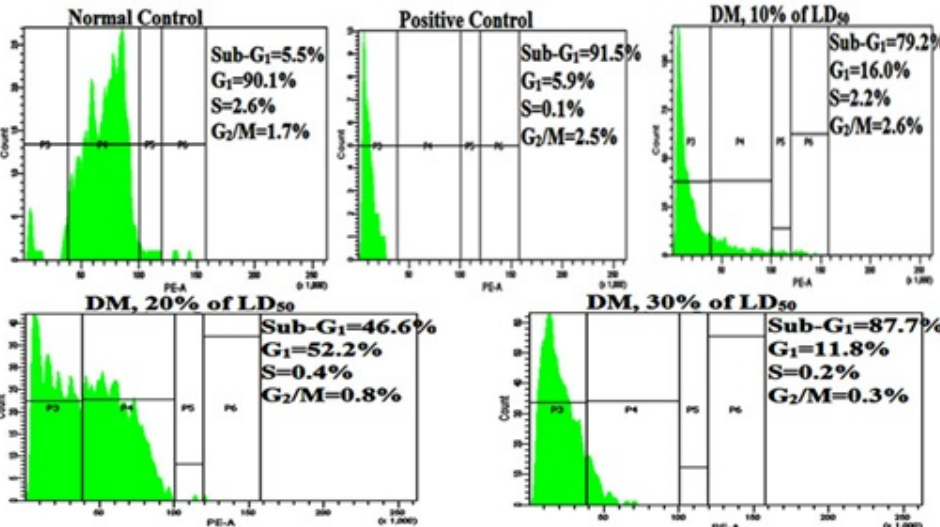
Figure 4. Analysis of cell cycle in lymphocyte cells of Dimethoate treated R. norvegicus by flow cytometry. Alteration in progression of cell cycle acquired from one experiment as function of DM treatment. G1, S, G2 / M in each image show percentage of cells normal phases of cell cycle, where SubG 1 exhibit percentage of cells that undergone apoptosis. Table 4. Flow cytometry-based cell cycle phase distribution analysis with propidium iodide staining in rat WBCs treated with di ff erent doses of Dimethoate at various durations. Groups